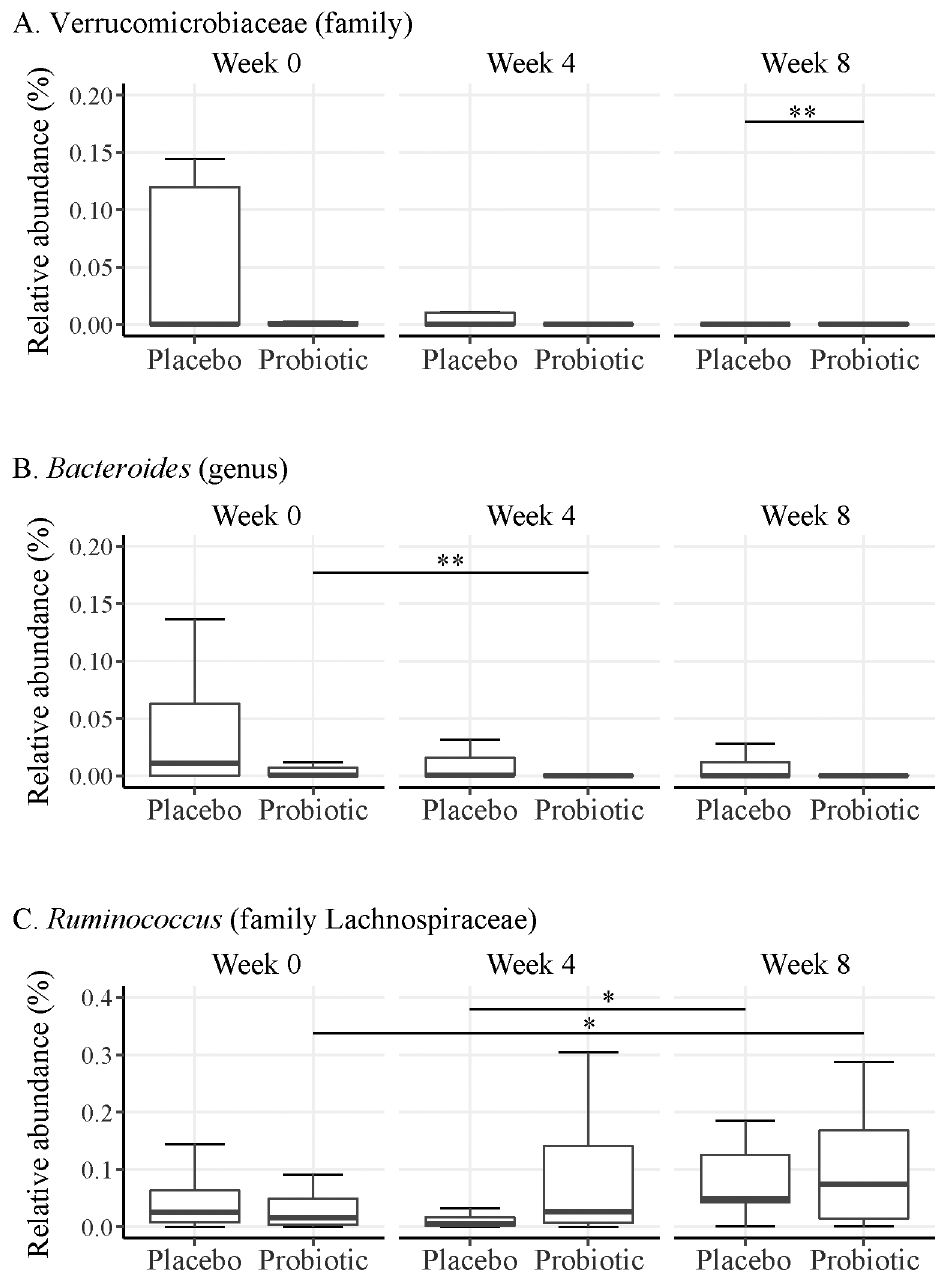
Fig 2. Taxa were found to be differentially abundant depending on treatment and time point. (A) Subjects in the probiotic group had a significantly lower abundance of the bacterial family Verrucomicrobiaceae at week 8 than placebo treated subjects; (B) Members of the bacterial genus Bacteroides were significantly reduced in abundance between weeks 0 to 4 in probiotic treated subjects; (C) Ruminococcus (family Lachnospiraceae) tended to be more abundant at week 8 than week 4 within the placebo group and at week 8 than week 0 within the probiotic group; (cid:3) 0.05 < p < 0.1 and (cid:3)(cid:3) p (cid:20) 0.05.